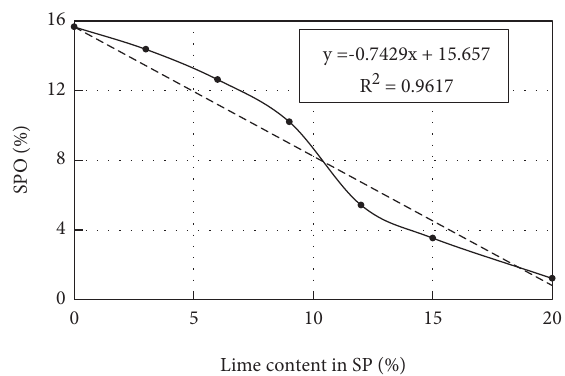
Figure 7: Swelling potential versus lime content in SP (RAR � 35.84%).